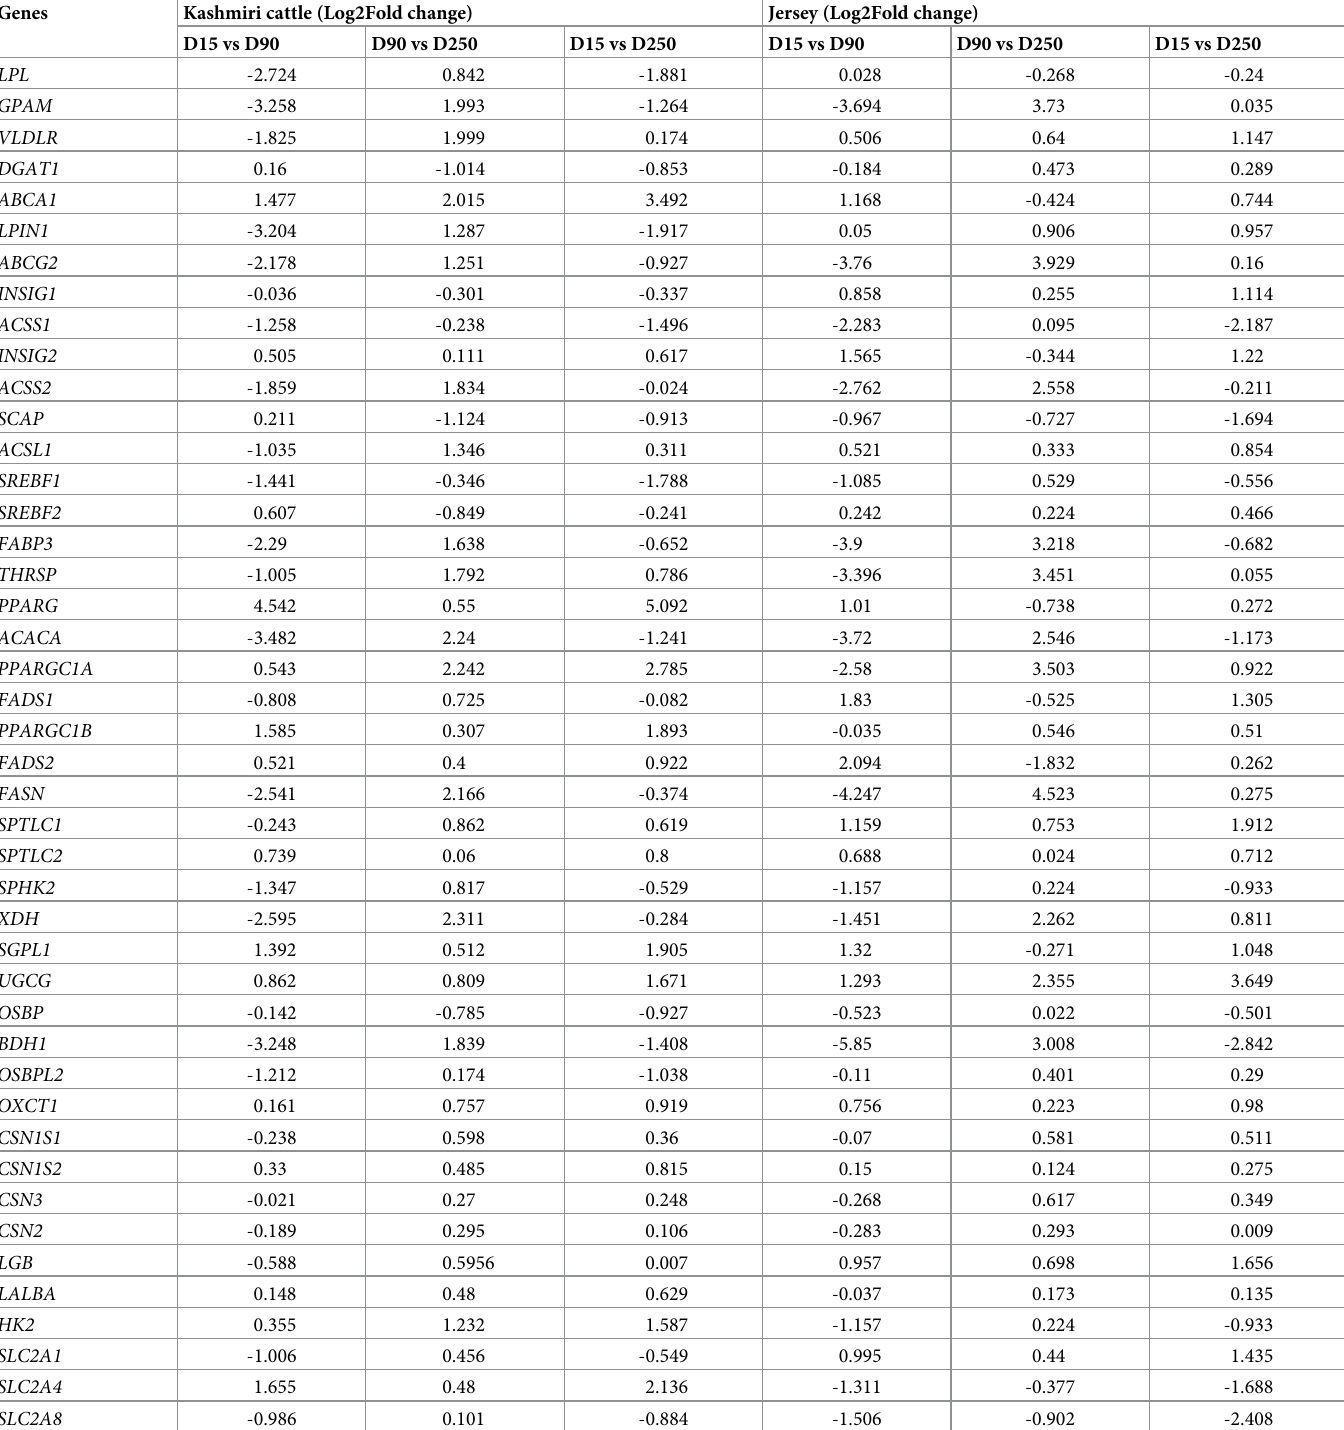
Table 5. Differentially expressed milk candidate genes in mammary epithelial cells for milk quality and yield traits between different stages of lactation in Kashmiri and Jersey 1